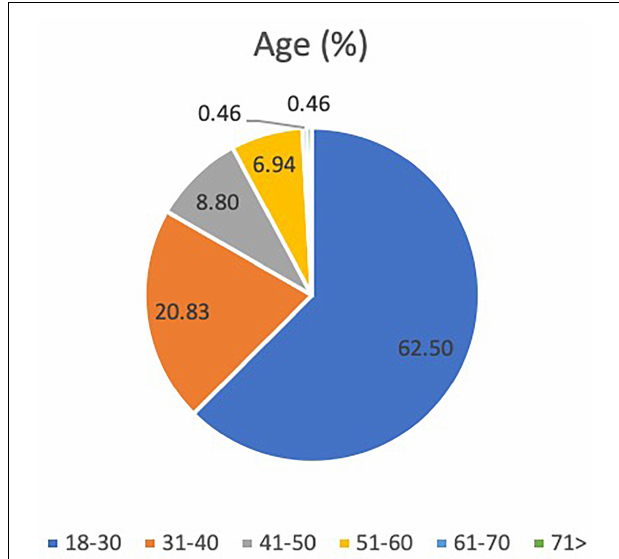
FIGURE 4 | Percentage of questionnaire participants by